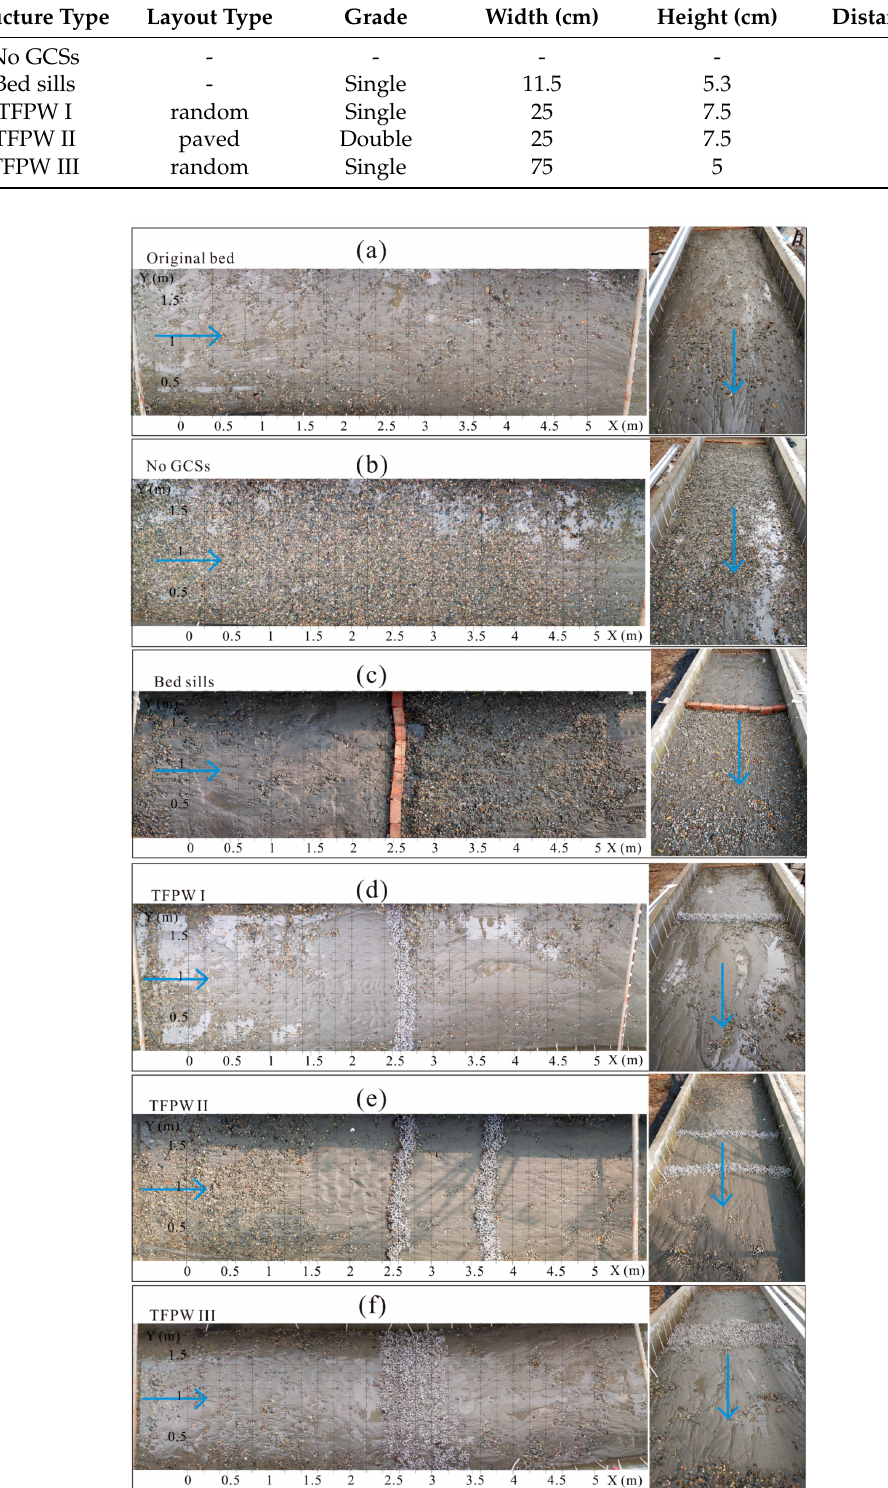
Figure 5. Pictures of the bedforms: ( a ) bedforms of the original bed before scouring; ( b ) armor layer after clear scour without any GCSs; ( c ) bedforms of the riverbed with bed sills after scouring; and ( d – f ) bedforms of the riverbed with TFPW I, TFPW II and TFPW III after scouring,